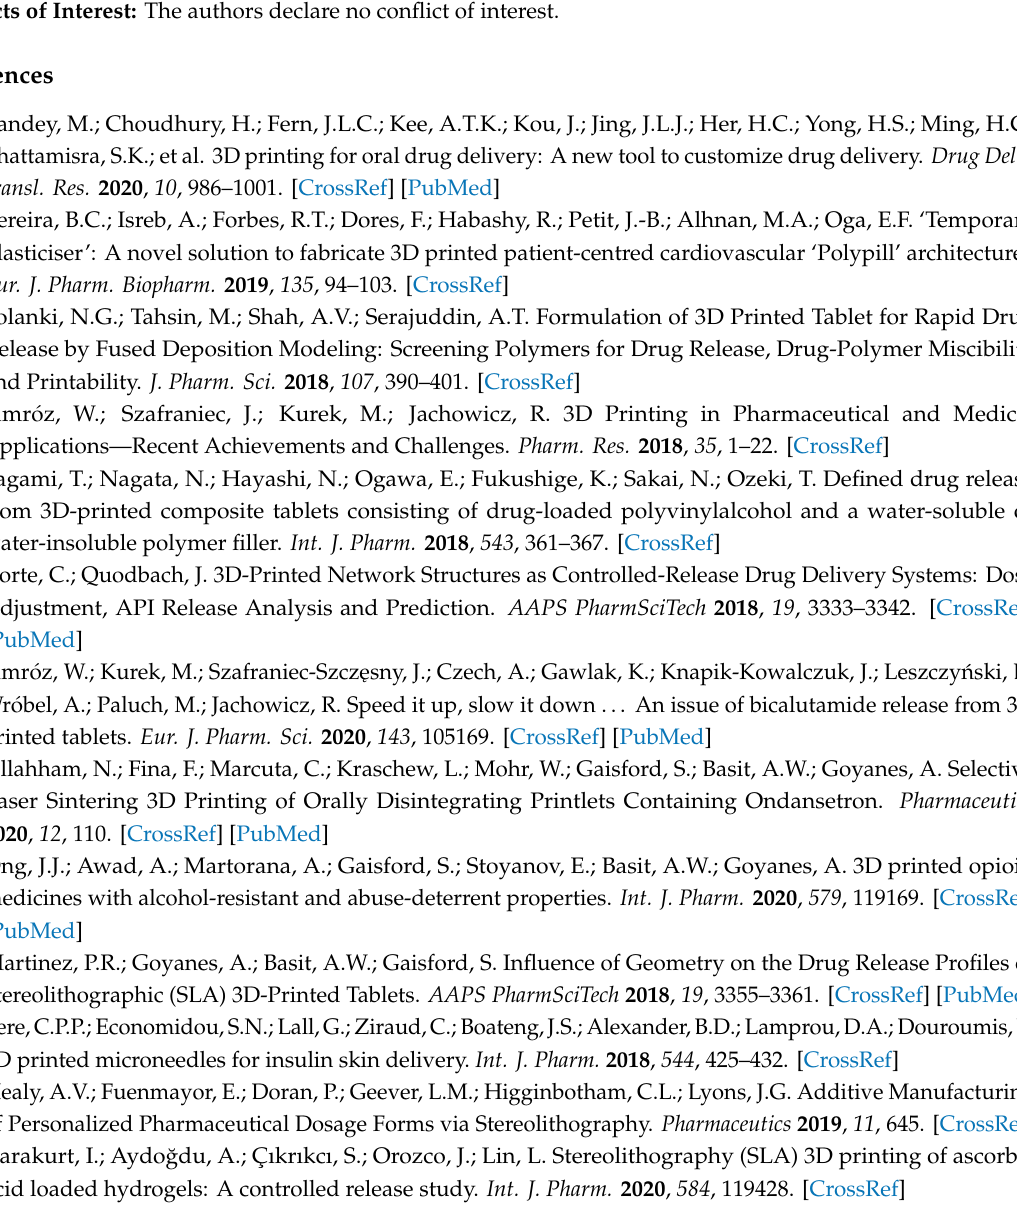
Figure S1: 3D printed itraconazole-loaded tablet with 20% infill density; Figure S2: 3D printed itraconazole-loaded tablet with 35% infill density; Figure S3: 3D printed itraconazole-loaded tablet with 60% infill